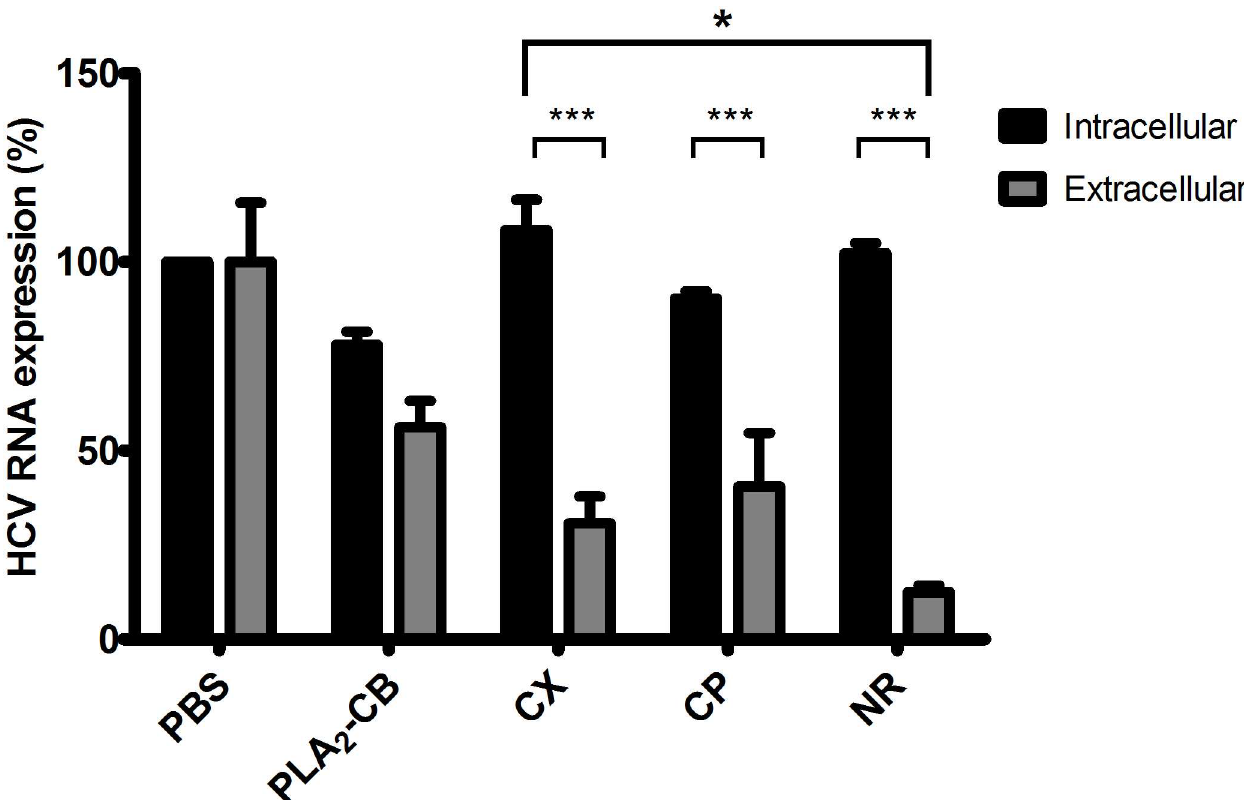
Fig 8. Antiviral activity of toxins on HCV release. Huh-7.5cells previously infected with JFH-1 virus was plated 48 h prior treatment. The toxins were added at 10 μ g/mL and incubatedfor 24 h. Supernatant was collectedand cells were harvested, and intra and extracellular RNA were quantified by qPCR. PBS was used as negativecontrol and naringenin(NR) at 400 μ M was used as positive control of HCV secretion. Mean values of three independent experiments each measured in triplicate includingthe standarddeviationare shown. P < 0.001 was considered